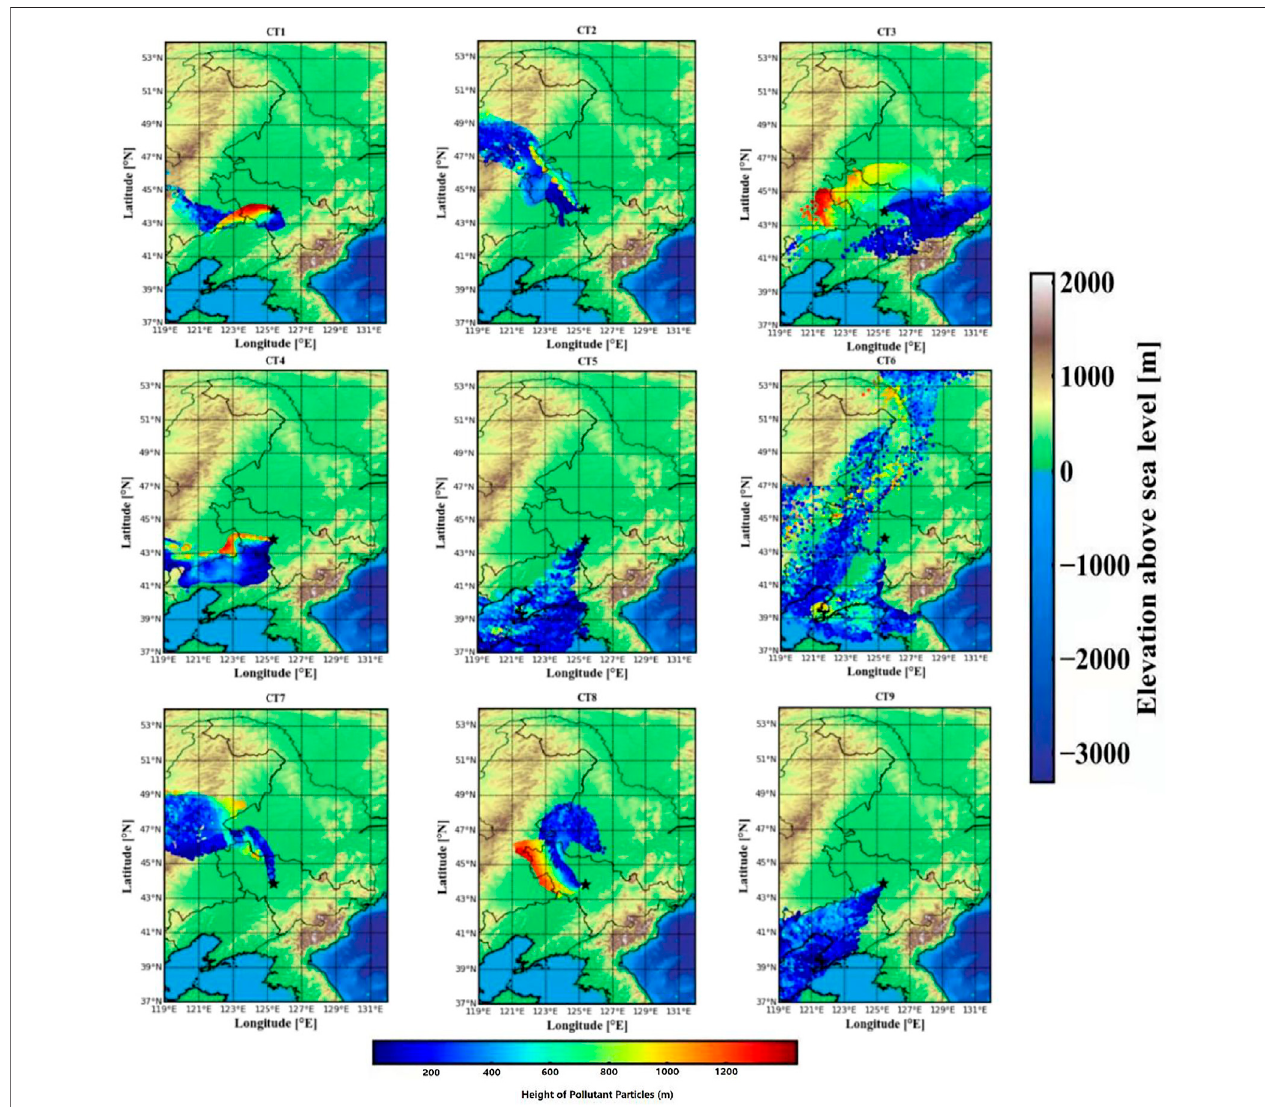
FIGURE 11 | Backward plume trajectory of particles during heavy pollution periods of PM2.5 under nine circulation types during the lockdown. The colour bar below indicates the height of the particles from surface and that on the right represents the terrain height.